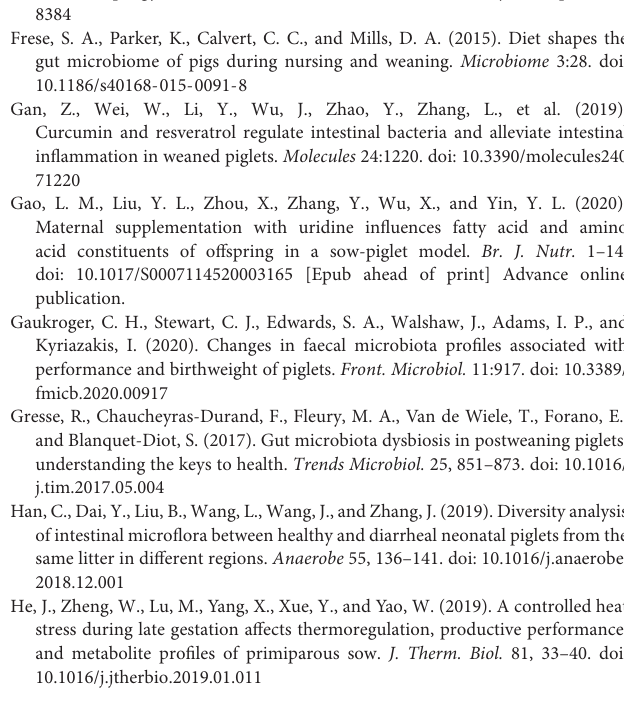
Supplementary Figure 1 | The boxplot of differences on bacterial community diversity and richness. (A) Good’s coverage index; (B) Chao1 index; (C) Observe